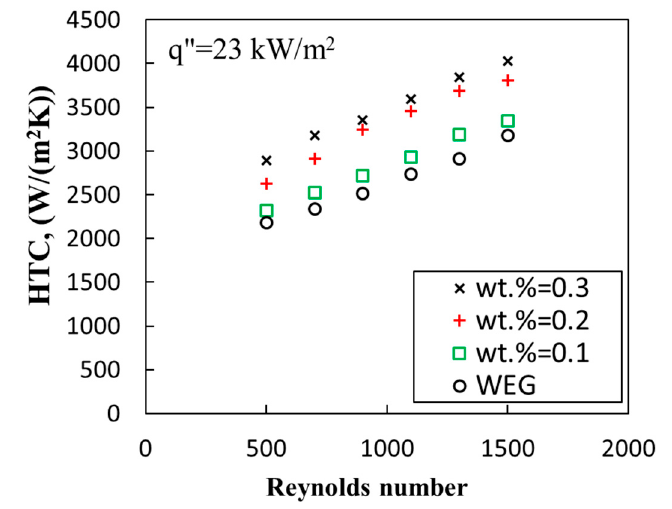
Figure 4. Variation of the HTC of the system with Reynolds number.